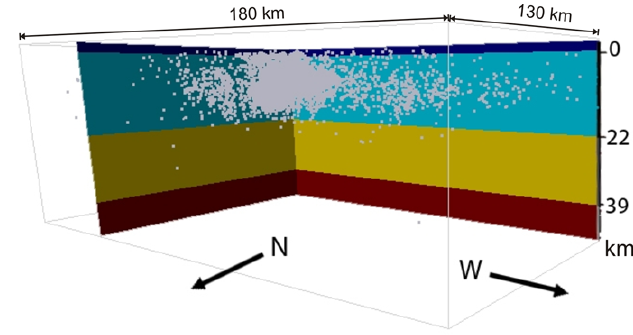
Figure 1. A simple 1D model composed of two homogeneous layers over- lying a homogeneous half-space. White dots, hypocenters estimated using the Hypo71 algorithm.